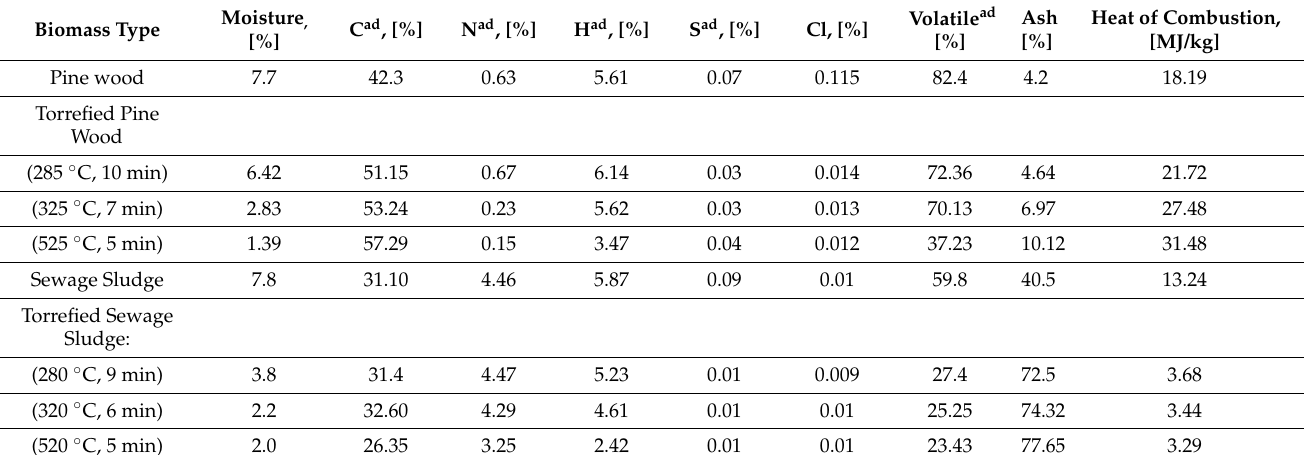
Table 3. Determined values of the heat of combustion of the obtained torrefaction